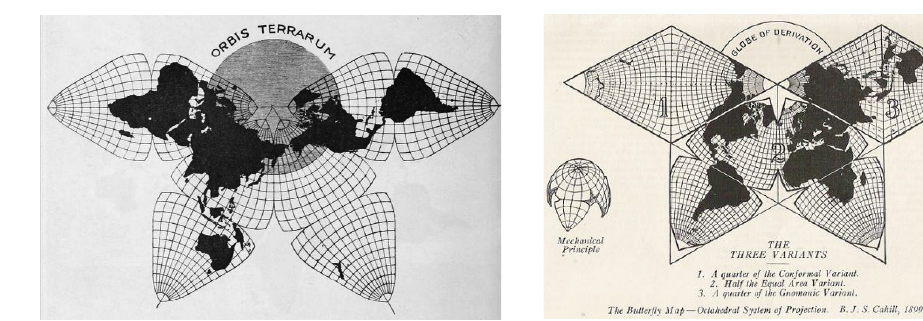
Fig 11. B.J.S. Cahill’s map (source: Gene Keyes website)